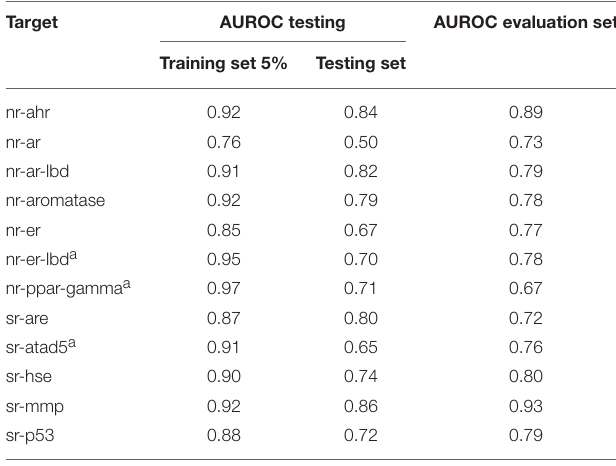
TABLE 3 | AUROC values obtained for the best models selected for final predictions. Target AUROC testing AUROC evaluation